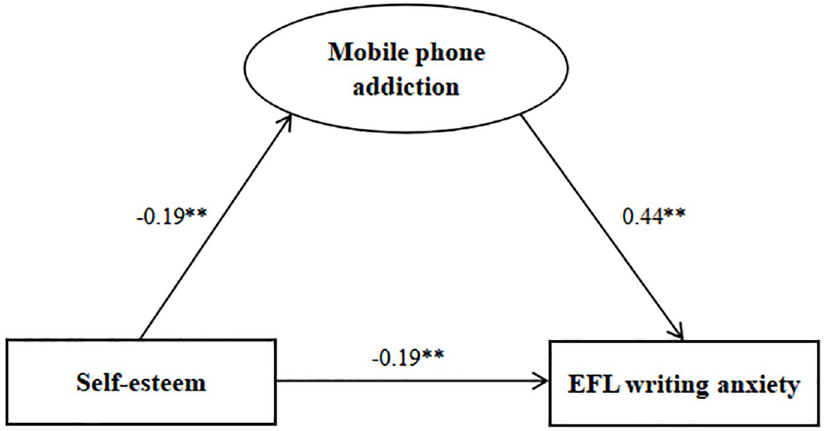
Fig 2. Standardized solutions for the structural equation model of the mediating effect of mobile phone addiction between self-esteem and EFL writing anxiety. Note: ** P < 0.01. Standardized path coefficients are illustrated on the unidirectional arrow paths. ** The coefficient of the path is significant at the P < 0.01 level. Abbreviations: EFL, English as a foreign language.